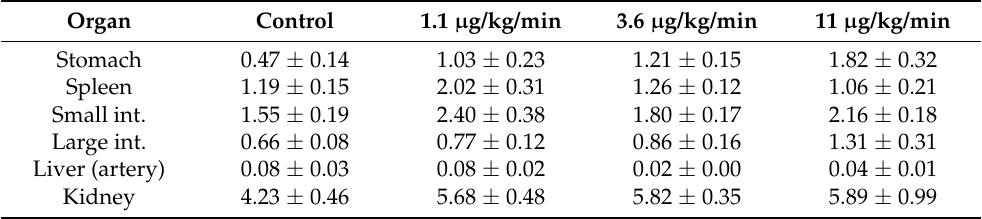
Table 2. Organ blood flow in mL/min/g in dogs during different dopexamine infusion rates extracted from